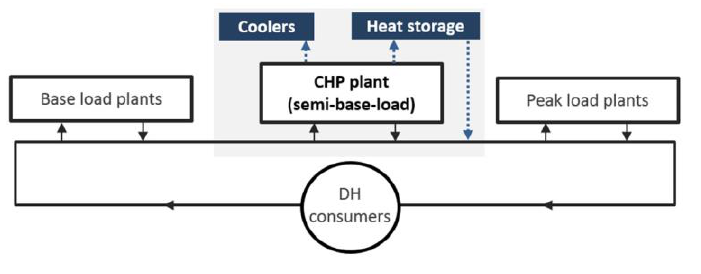
Fig. 3. Block diagram of the evaluated DH